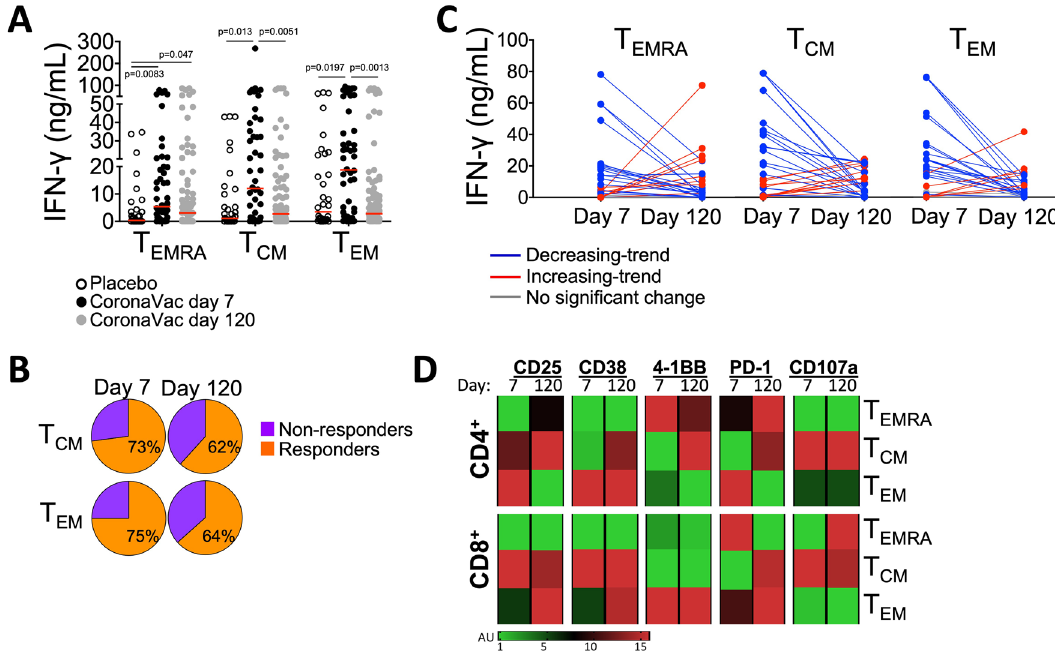
Figure 2. Modulation of IFN-γ secretion and activation markers on memory T cell subtypes indicated the efficacy of whole virion vaccination on cellular immunity. T EMRA , T CM , and T EM obtained from the placebo group and the CoronaVac group on day 7 and day 120 were co-cultured with the S1-loaded mDCs. IFN-γ secreted into the supernatants and the expression of CD25, CD38, 4-1BB, PD-1, and CD107a markers were assessed by flow cytometry-based methods after 96 h of incubation. ( A ) The amount of IFN-γ secreted by memory T cells is shown. ( B ) The percentage of participants whose T cells were responded to the S1-loaded mDCs and secreted more IFN-γ than the median value of the placebo group is demonstrated as “responders”. ( C ) The IFN-γ secretion capacity of